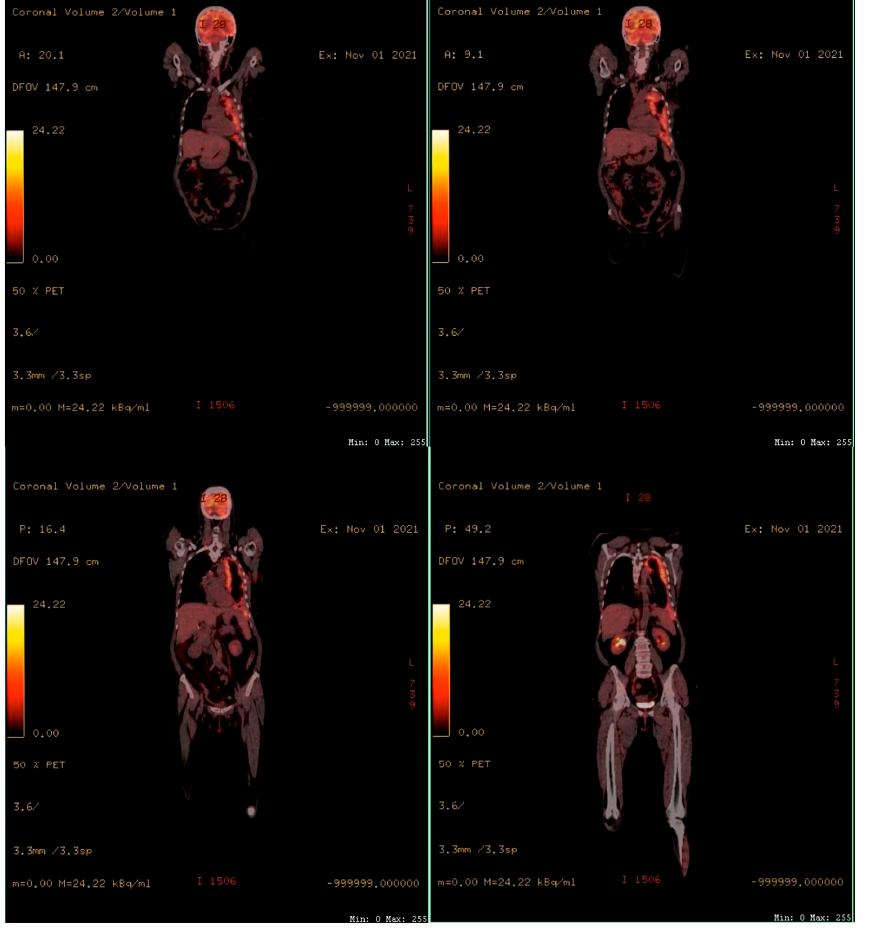
Figure 2. PET-CT scans showing thickening of the left pleura from top to base. No metastases or invasion of the chest wall, mediastinum, or diaphragm.